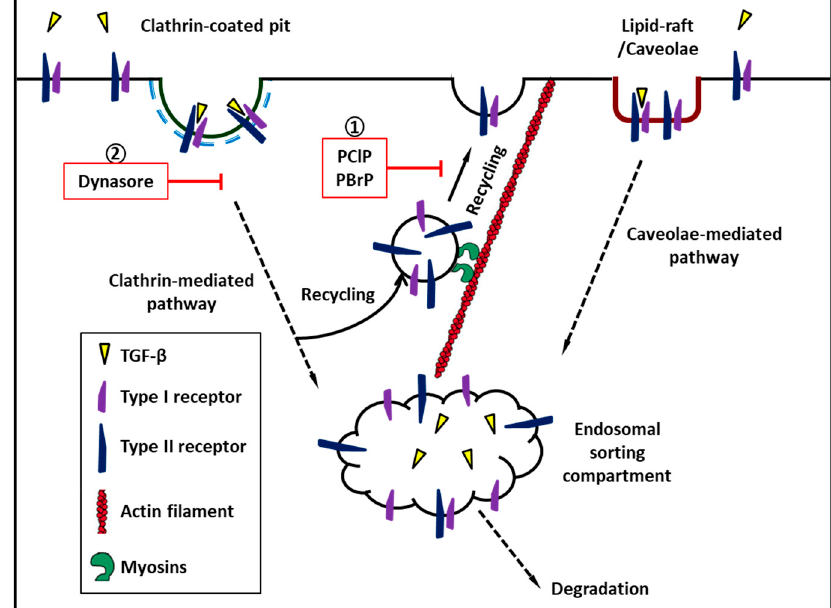
Figure 2. Myosins regulate recycling of transforming growth factor- β receptor to cell surface. ① Pentachloropseudilin and pentabromopseudilin suppress recycle of TGF- β receptor to plasma membrane. ② Dynasore, a cell-permeable inhibitor of dynamin which inhibits clathrin-mediated endocytosis of TGF- β receptors.